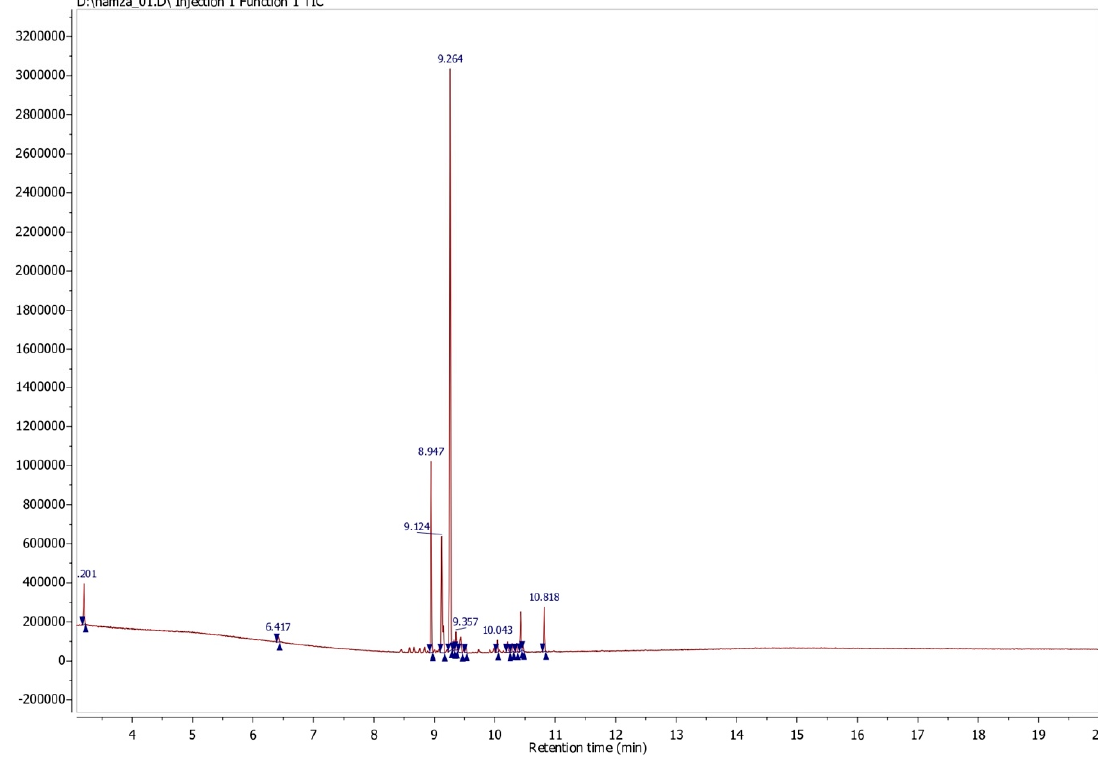
Figure 1. Cedarwood GC/MS chromatogram.